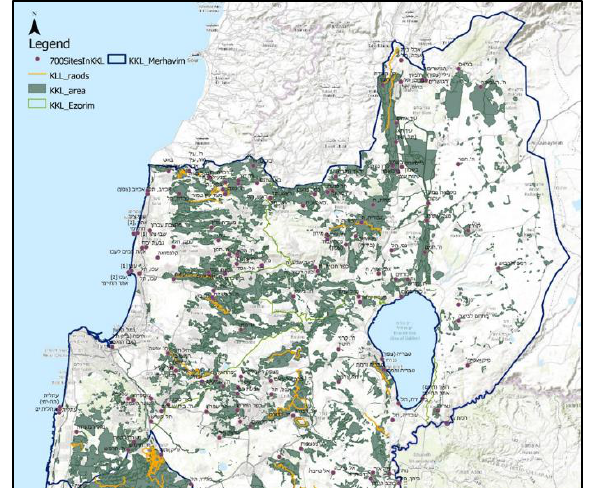
Figure 5. Compilation of forest scenic routs managed by the JNF and potential archaeological sites for conservation along the roads in the North